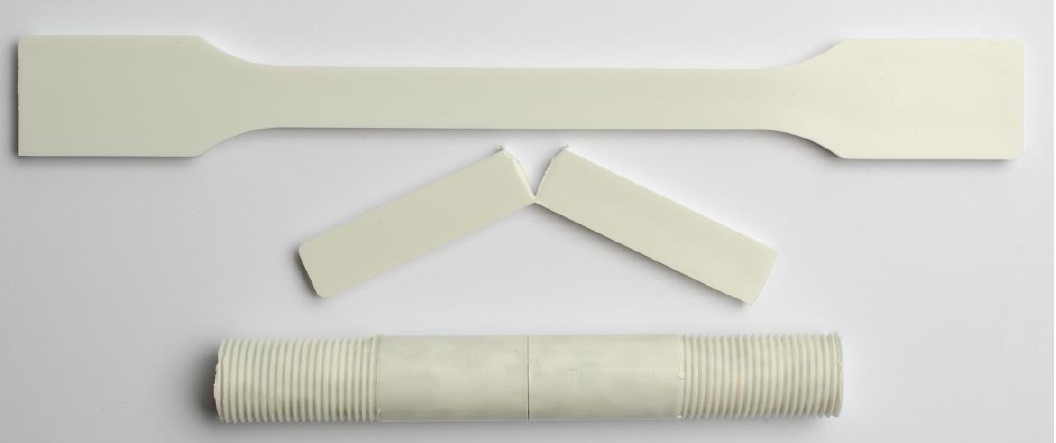
Figure 3. Image of the specimens used in this work made from the PE-HD recyclate rPE-A; from top down: a multipurpose specimen, a Charpy notched impact tested bar specimen, and a cracked round bar specimen.